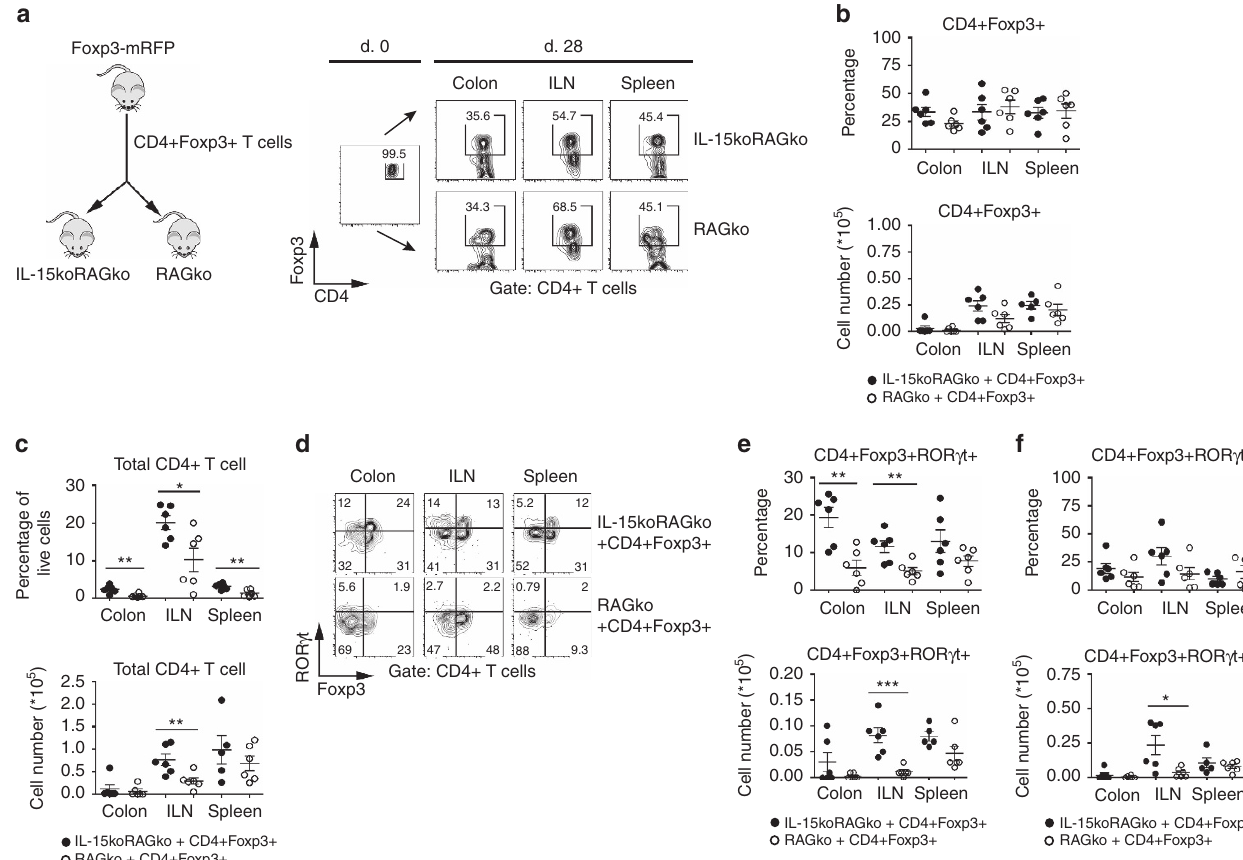
Figure 1 | Regulatory T cells acquire ROR c t expression on transfer into IL-15-deficient immune-deficient hosts. ( a ) About 2 (cid:3) 10 5 CD4 þ Foxp3 þ T lymphocytes (Treg) purified from Foxp3-mRFP mice were transferred into RAG2ko or IL-15koRAG2ko mice, which were killed 28 days later: Foxp3 expression by CD4 þ T cells before (day 0, left panel) and after transfer in the colon, the inguinal lymph nodes (ILN) and the spleen of injected IL-15koRAG2ko and RAG2ko mice (right panel). ( b ) Percentage among live CD4 þ Tcells (upper panel) and total number (lower panel) of CD4 þ Foxp3 þ Tcells in the colon, the ILN and the spleen of IL-15koRAG2ko and RAG2ko recipients after Treg transfer. ( c ) Frequency among all live cells (upper panel) and number (lower panel) of total CD4 þ Tcells in the colon, the ILN and the spleen of IL-15koRAG2ko and RAG2ko hosts. ( d ) Expression of Foxp3 and ROR g t by CD4 þ Tcells recovered from the colon, the ILN and the spleen of IL-15koRAG2ko and RAG2ko hosts. ( e ) Percentage among live CD4 þ Tcells (upper panel) and number (lower panel) of Foxp3 þ ROR g t þ CD4 þ Tcells isolated from the colon, the ILN and the spleen of IL-15koRAG2ko and RAG2ko hosts. ( f ) Percentage among live CD4 þ Tcells (upper panel) and number (lower panel) of Foxp3-ROR g t þ CD4 þ Tcells in IL-15koRAG2ko and RAG2ko hosts. ( b – f ) Data compiled from two separate experiments with at least three mice per group. Black circles represent IL-15koRAG2ko hosts, open circles RAG2ko hosts. Each symbol represents an individual mouse. All graphs indicate mean values; error bars denote s.e.m.; * P o 0.05; **0.01 o P o 0.05; *** P o 0.001(Student’s t -test values). NATURE COMMUNICATIONS|7:10888|DOI: